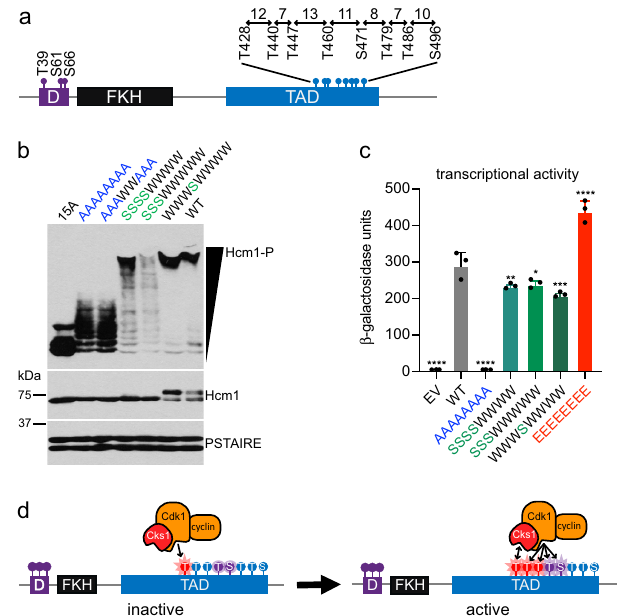
Fig. 7 | Phosphorylation of sites 460 and 471 depends on Cks1. a Schematic showing the spacing between phosphosites in the TAD. b Phos-tag western blot showing phosphorylation of the indicated Hcm1proteins (top panel) and standard western blots showing expression of the indicated proteins (lower panels). Hcm1 was detected with antibody against the 3V5 tag, PSTAIRE is shown as a loading control. Representative images from n =3 biological replicates are shown. c Transcriptional activation assay of constructs containing the LexA-DBD fused to the Hcm1 TAD with the indicated phosphosite mutations or WT or empty vector (EV) controls. Black represents EV, gray represents WT, blue represents hcm1-8A , red represents hcm1-8E , and shades of green represent mutants with potential T priming sites mutated to S. Error bars represent standard deviation, shown is an average of n =3 replicates. Signi fi cance was tested using repeated measures one- way ANOVA with Dunnett ’ s multiple comparisons test. Asterisks indicate sig- ni fi cantlydifferentfromWT,**** P <0.0001,*** P <0.0005,** P <0.005,* P <0.05.EV,